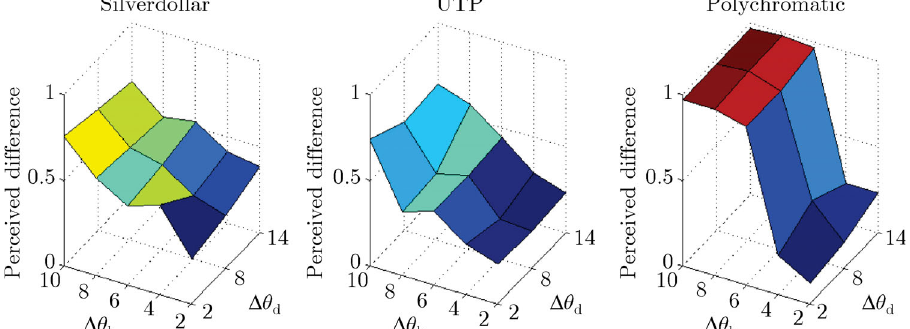
Fig. 15 Psychometric data from the experiment showing perceived difference as a function of sampling steps along θ h , and θ d for Silverdollar , UTP , and Polychromatic .